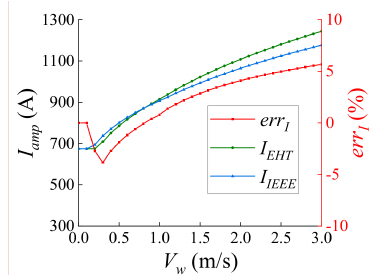
Figure 13. Comparison of conductor ampacity results from EHT model and IEEE standard under di ff erent wind